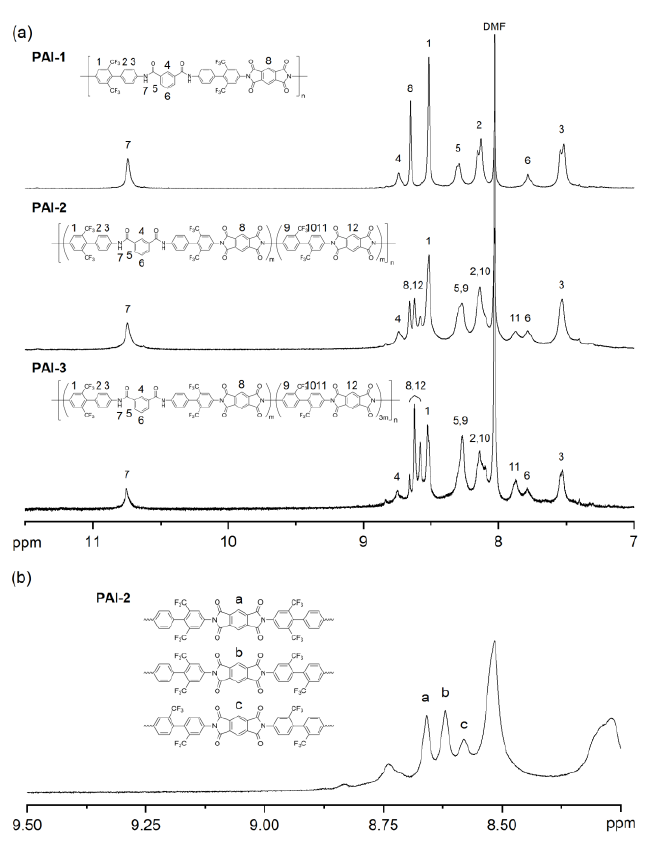
Figure 2. ( a ) 1 H NMR spectra of the PAIs (DMF- d 7 , 25 °C). ( b ) magnified 1 H NMR of PAI-2 .